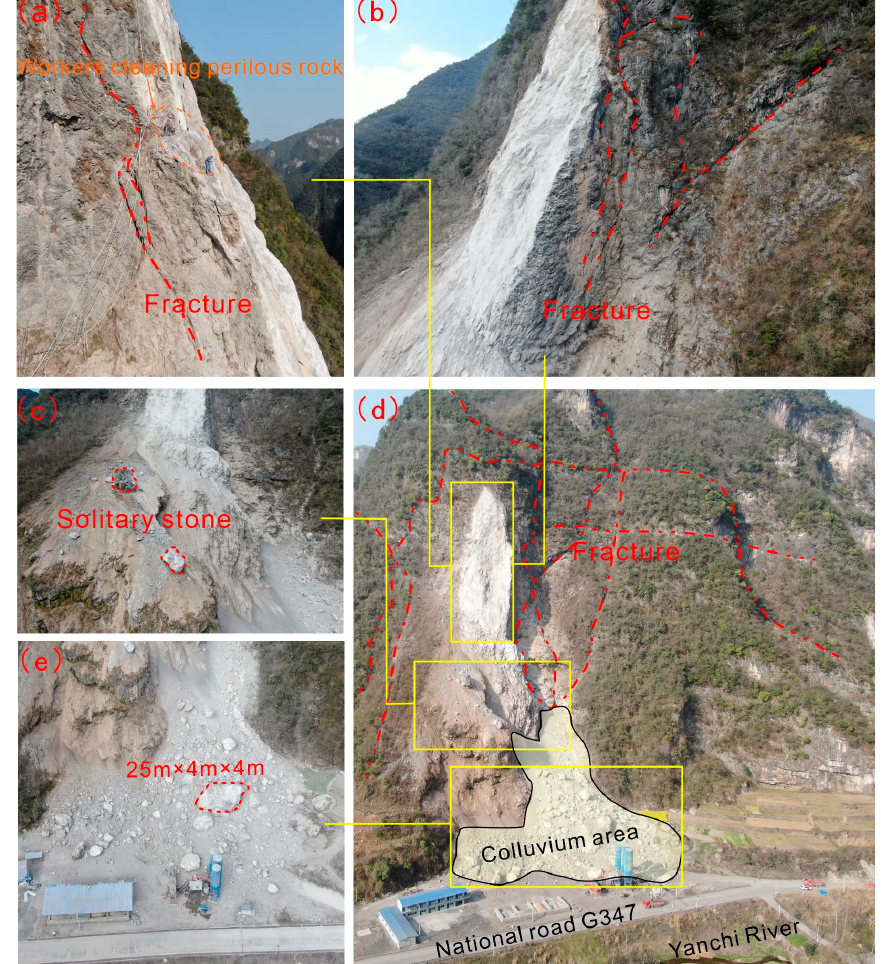
Figure 8. ( a ) Fractures ran through the rear edge on the west side of the residual perilous rock; ( b ) Fractures ran through the rear edge on the east side of the residual perilous rock; ( c ) Solitary stones on the slope; ( d ) Full view after the collapse of the perilous rock mass; ( e ) Colluvium area of fallen rocks at the slope toe.